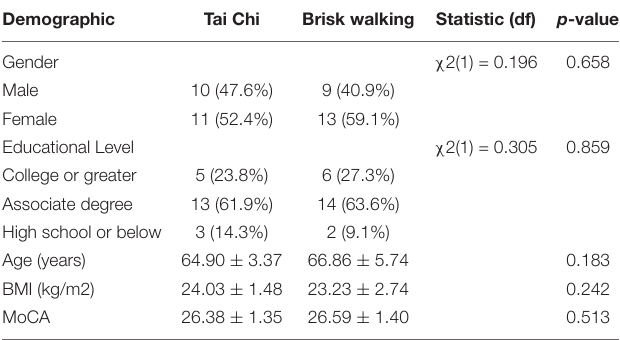
TABLE 1 | Demographic